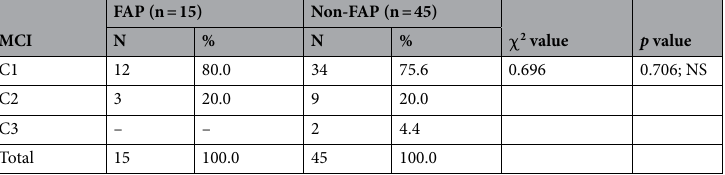
Table 2. Distribution of mandibular cortical index (MCI) in the two groups. Results are given as percentages. p -values were determined using Chi-Square Test ( χ 2 ); NS: p > 0.05. C1 the endosteal margin of the cortex is even and sharp on both sides, C2 the margin shows semilunar defects, lacunar resorption appearance and/or it seems to form endosteal cortical residues in one or both sides, C3 the cortical layer forms heavy endosteal residues and it is clearly porous, MCI mandibular cortical index, N number, NS not significant.